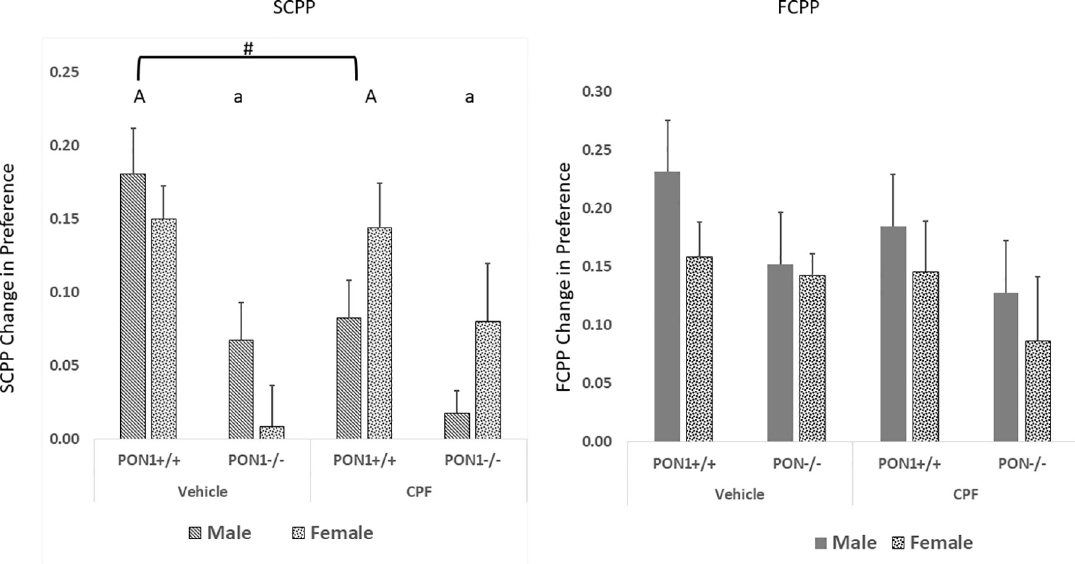
Fig 5. Left panel SCCP. Mean + SEM change in preference for the bedding conditioned to a social stimulus. A vs a. Main effect of genotype. #—Main effect of Sex. Number of mice in parentheses for each group: Male PON1 +/+ Vehicle (5); CPF (4); Female PON1 +/+ Vehicle (4); CPF (3); Male PON1 -/- Vehicle (6); CPF (5); Female PON1 -/- Vehicle (5) CPF (4) Right panel FCPP. Mean + SEM change in preference for the bedding that was conditioned to a food stimulus. Number of mice/group: Male PON1 +/+ Vehicle (10); CPF (5); Female PON1 +/+ Vehicle (10); CPF (8); Male PON1 -/- Vehicle (6); CPF (5); Female PON1 -/- Vehicle (4); CPF (6).